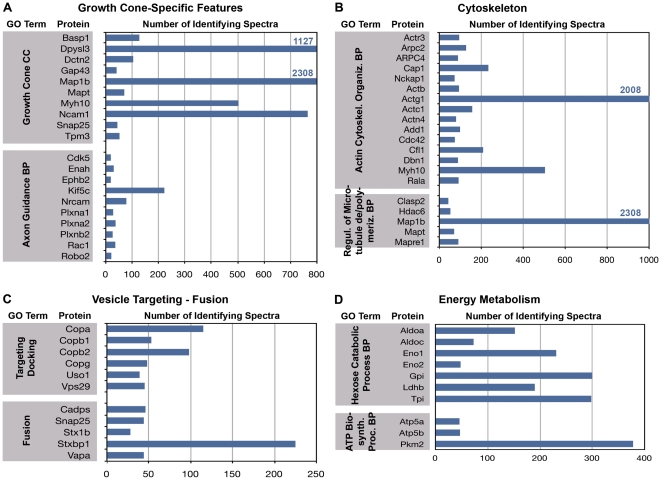
Proteins with the most abundant spectral counts under the following GO Terms: (A) “Growth Cone” (cytoplasmic component, CC) and “Axon Guidance” (biological process, BP); (B) “Actin Cytoskeletal Organization” (BP) and “Regulation of Microtubule Polymerization/Depolymerization” (BP); (C) “Vesicle Targeting/Docking” (BP) and “Vesicle Fusion” (BP); and (D) “Hexose Catabolic Process” (BP) and “ATP Biosynthetic Process” (BP).Note that scales are different for each panel.